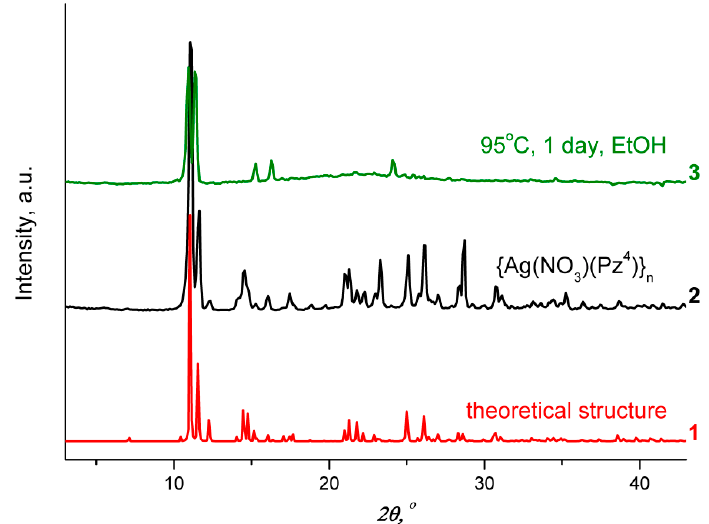
Figure 7. XRD patterns: (1) theoretical pattern of {Ag(NO 3 )(µ 2 -Pz 4 )} n emulated from single-crystal experiment; (2) compound {Ag(NO 3 )(µ 2 -Pz 4 )} n ; (3) products of {Ag(NO 3 )(µ 2 -Pz 4 )} n degradation (solvothermal synthesis at ethanol solution during one day at 95 °C).